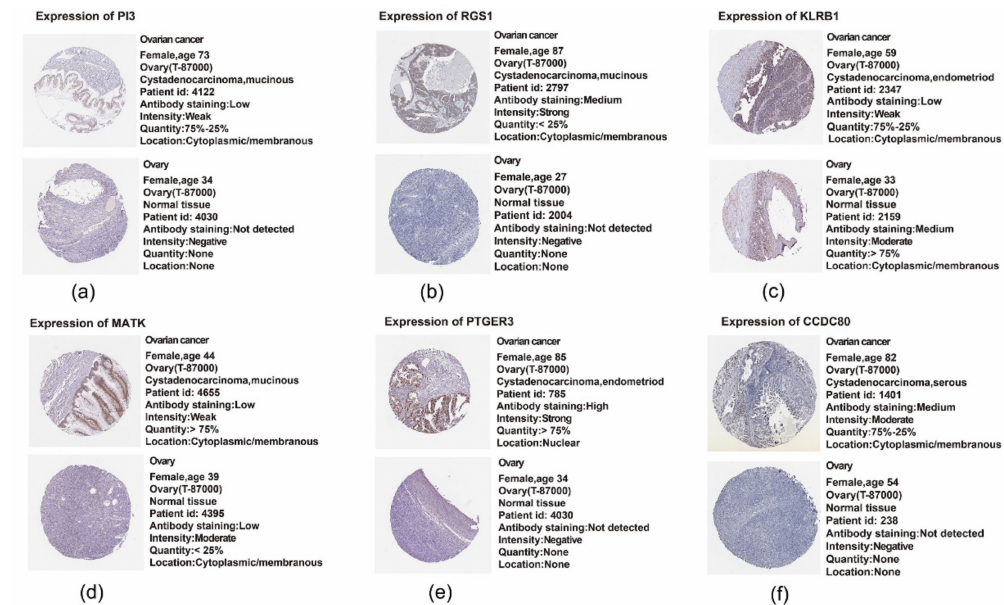
Figure 11. Translational level validation of six genes from the 11-gene signature using the Human ProteinAtlas(HPA):( a )expressionofPI3; ( b )expressionofRGS1; ( c )expressionofKLRB1; ( d )expression of MATK; ( e ) expression of PTGER3; ( f ) expression of